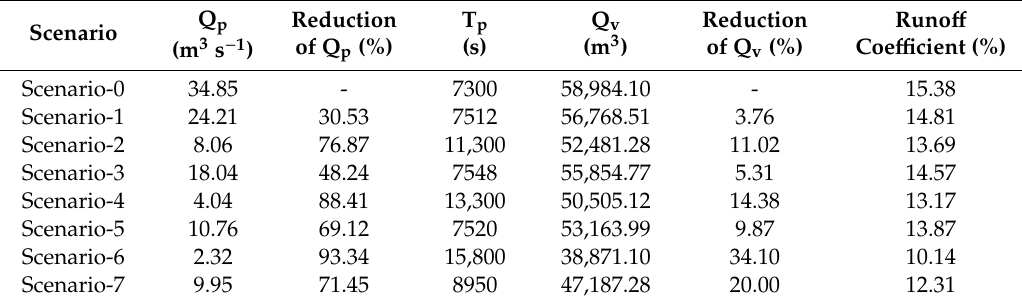
Table 5. Flood characteristics under di ff erent